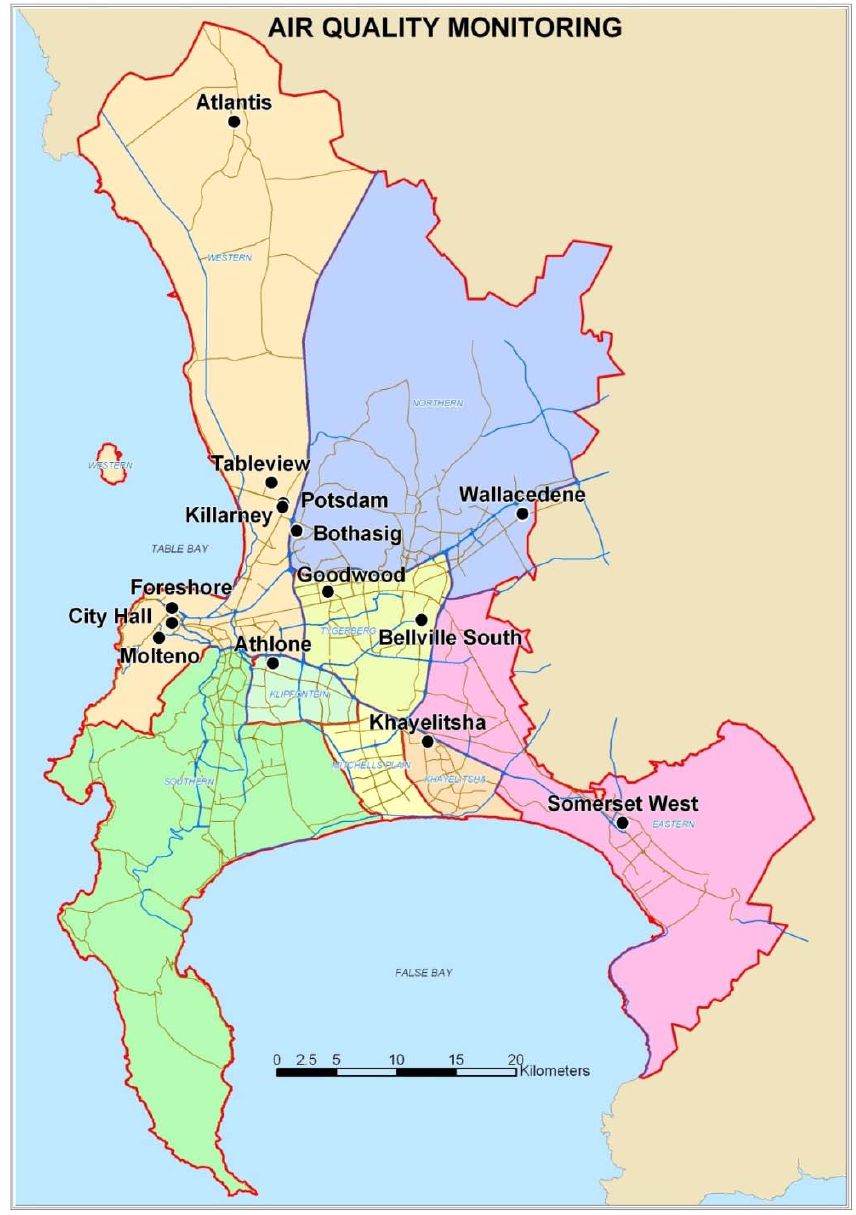
Figure A1. Map of the air quality monitoring network in Cape Town, South Africa during 2012  4 